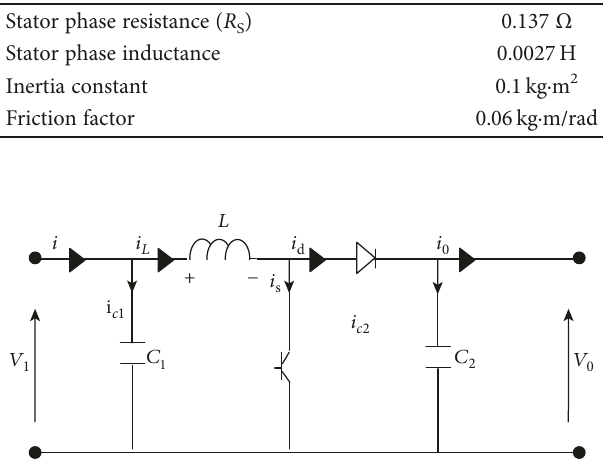
Figure 7: The boost converter circuit.